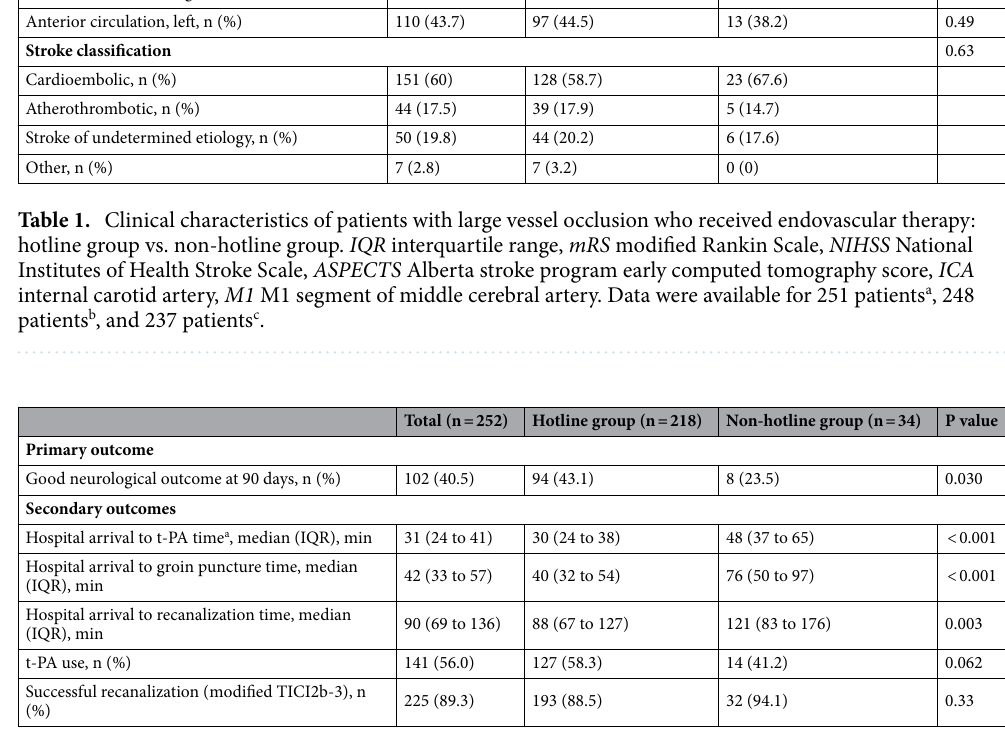
Table 2. Clinical outcomes in patients with large vessel occlusion who received endovascular therapy: Hotline group vs. Non-hotline group. IQR interquartile range, T-PA tissue plasminogen activator, TICI thrombolysis in cerebral infarction, ICH intracranial hemorrhage. a Only stroke patients who were treated with t-PA were